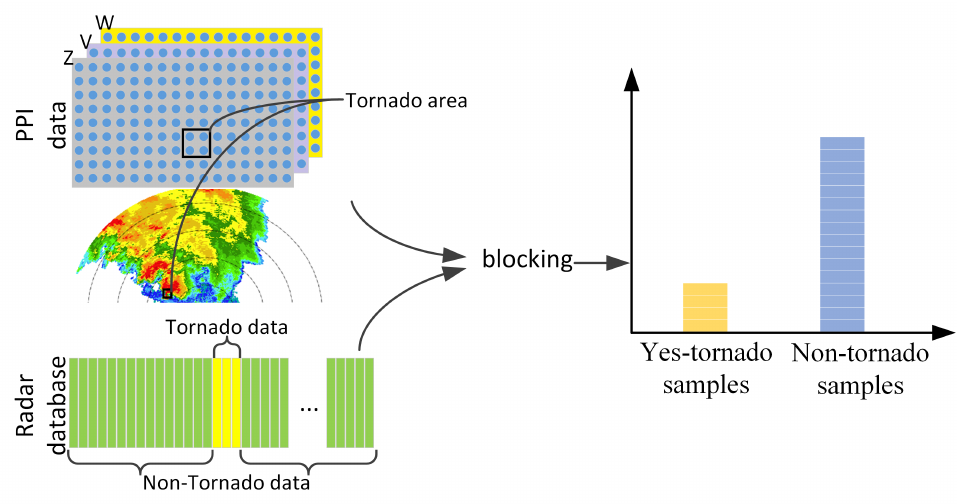
Figure 1. The class imbalance problem of tornado